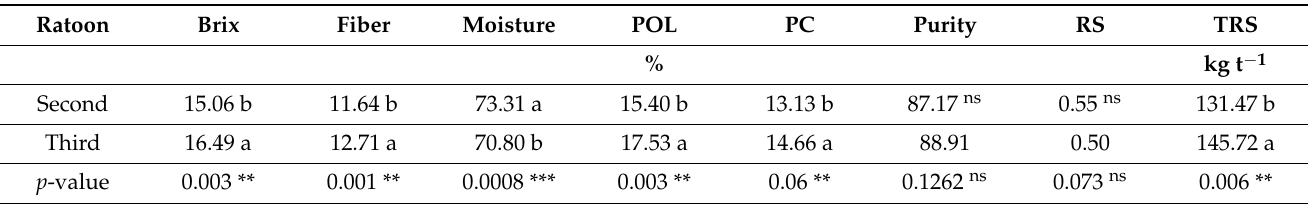
Table 4. Mean values of stalk technology quality parameters in two sugarcane ratoons. Growing seasons 2018/2019 and